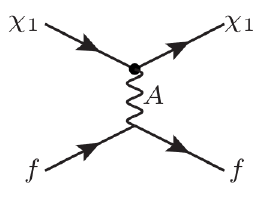
Figure 3: Diagram relevant to direct detection sourced from the dipole like operators. A stands for the photon field. The blob represents the effective